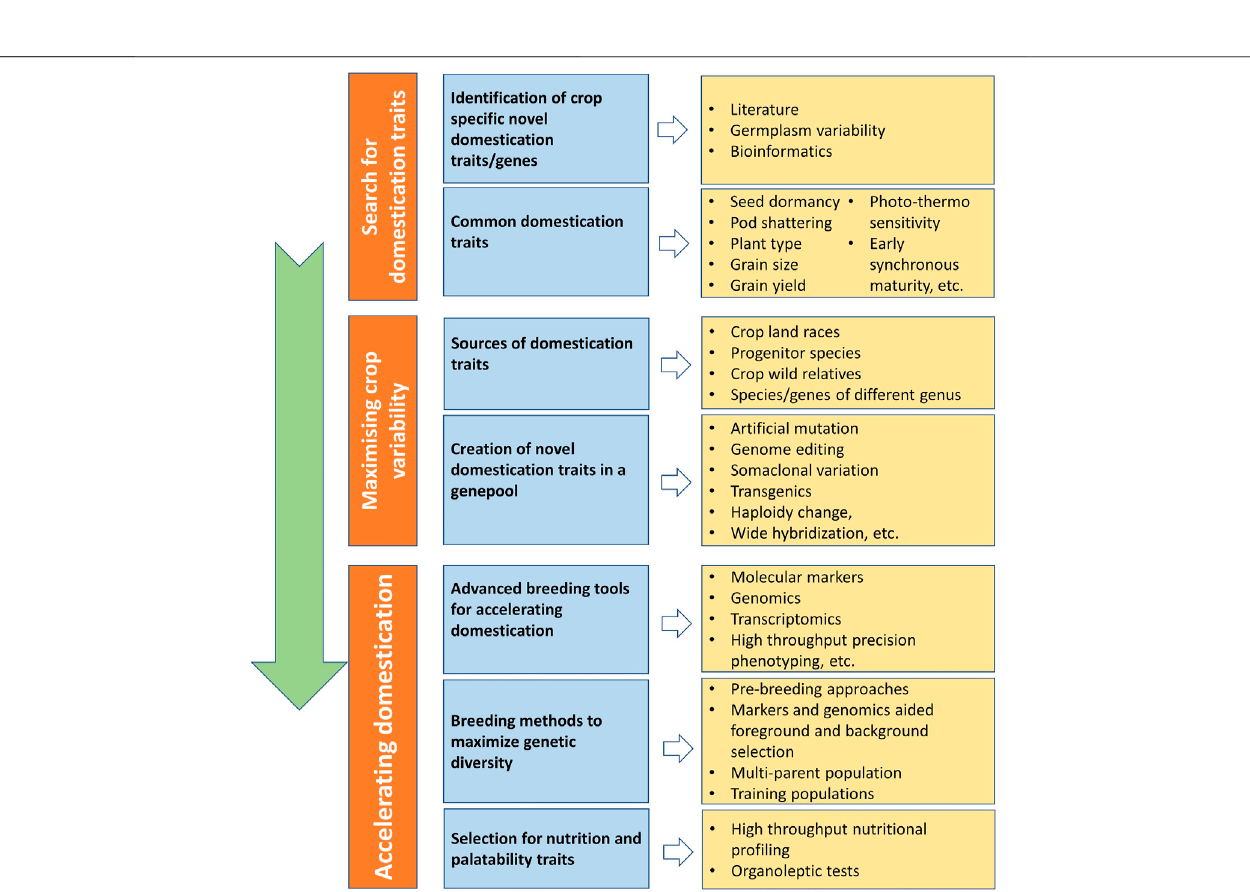
FIGURE 4 | Scheme for accelerating the domestication process of new crops with maximizing genetic diversity.